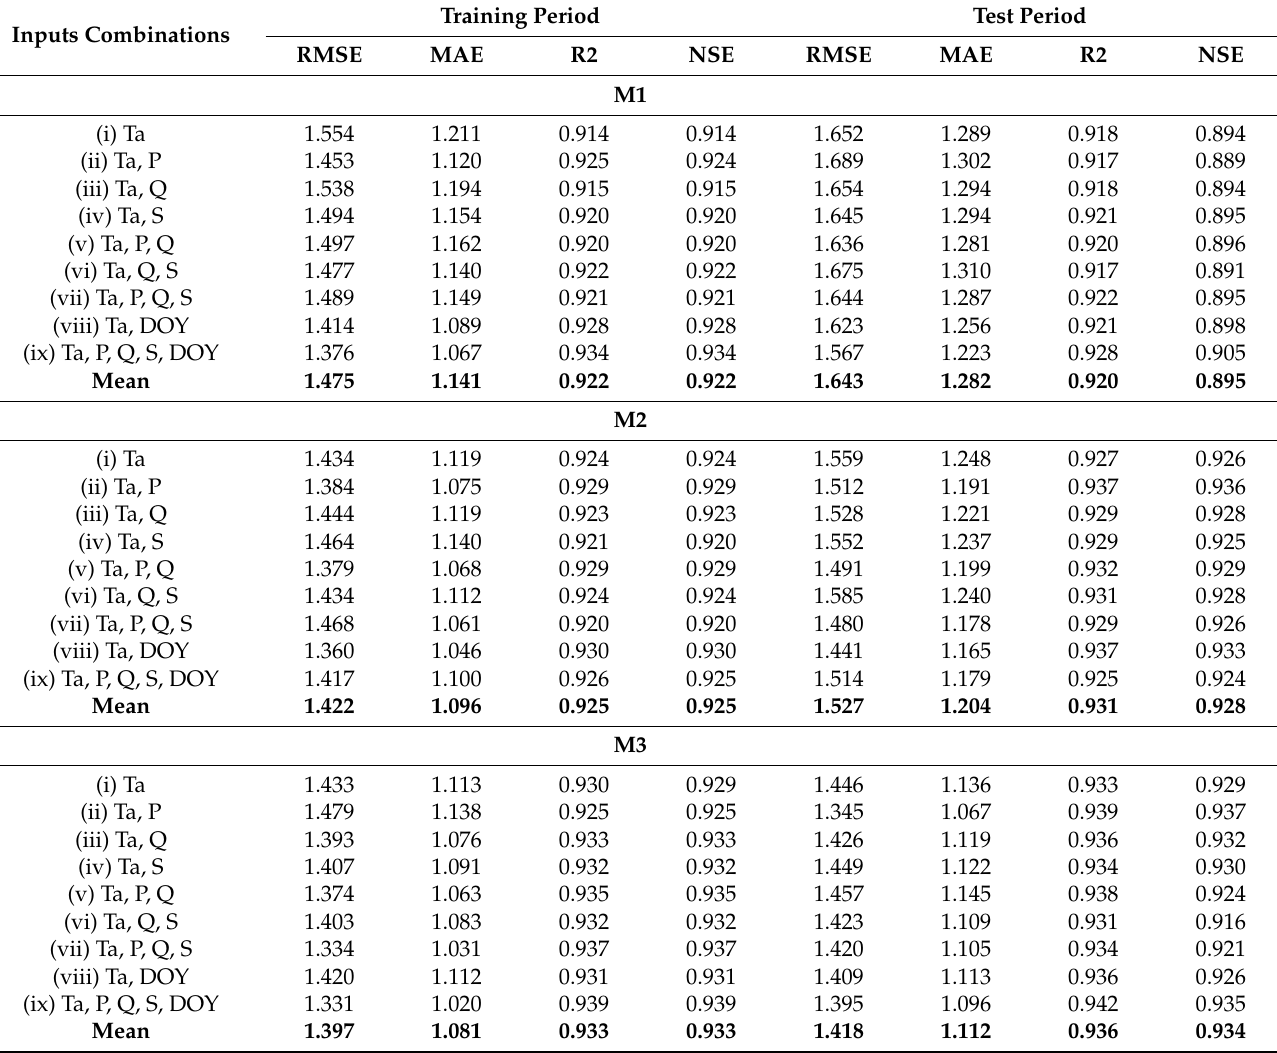
Table 4. Training and test statistics of the models for water temperature prediction—CNN. Inputs Combinations